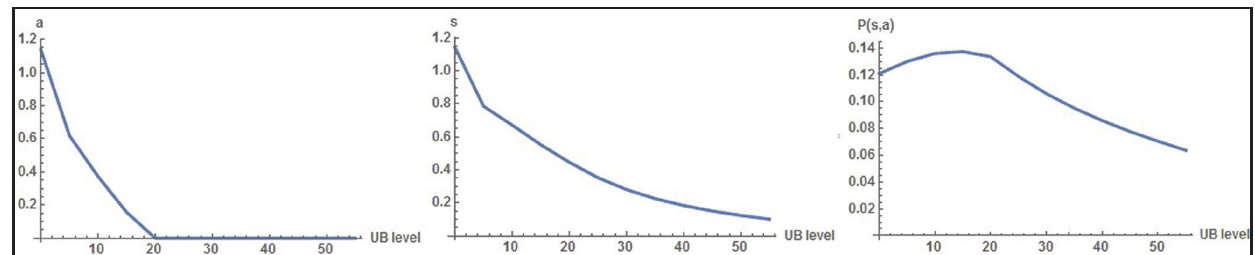
Figure 5 Incomplete Financial Markets [FM]. The three graphs show the level of a at the start of the unemployment spell in the model [FM] for different values of b . The functions and parameters are those of Table 1, except for f , which is now equal to zero; moreover, we allow the agent to get indebted up to 200 (two times the wage) and we assume that the agent has to repay her debt at the end of the T = B = 200 periods.